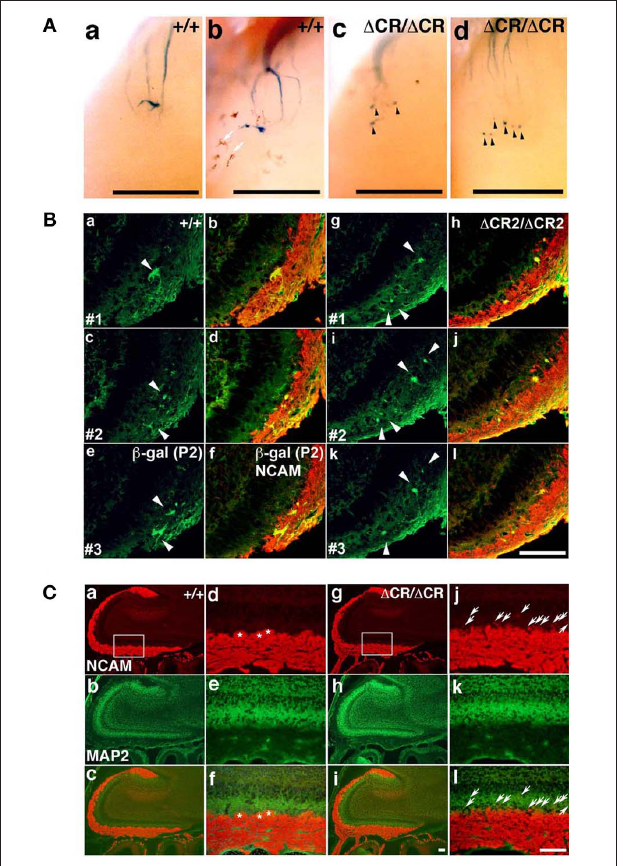
FIGURE 2 | Abnormal glomerular morphology in prenatal and neonatal Pcdha (cid:2) CR /(cid:2) CR mice. (A) Ectopic glomerulus-like structures of M71-expressing OSNs were found in neonatal Pcdha (cid:2) CR /(cid:2) CR mice by whole-mount observation. X-gal-stained lateral M71 glomeruli in whole-mounted OBs from WT (a, b) or Pcdha (cid:2) CR /(cid:2) CR ( (cid:2) CR/ (cid:2) CR ) (c, d) mice at P0. In Pcdha (cid:2) CR /(cid:2) CR mice, abnormal axonal projections from the olfactory nerve were often detected (arrowheads). Melanocytes (arrows) were visible on some of the whole-mount preparations of the olfactory bulbs. Scale bars, 500 μ m. (B) Sectional analysis of the coalescence of WT (a–f) and Pcdha (cid:2) CR 2 /(cid:2) CR 2 (g–l) P2 axons on embryonic day (E) 17.5. Serial sections of OBs were double-labeled with anti- β -galactosidase (for P2, green) and anti-NCAM (red) antibodies. There were more P2 glomerulus-like structures (arrowheads) in the Pcdha (cid:2) CR 2 /(cid:2) CR 2 ( (cid:2) CR2/ (cid:2) CR2 ) mice (See Figure 3A ). Scale bar, 100 μ m. (C) OBs in WT (a–c) and Pcdha (cid:2) CR /(cid:2) CR mice (g–i) were double-labeled with anti-NCAM (red) and anti-MAP2 (green) antibodies. Due to the orientation shown in panels (d) and (j), in Pcdha (cid:2) CR /(cid:2) CR mice, the OSN axons appeared to extend beyond the normal confines of the glomerular layer and often terminated as an intensely stained spatially restricted and condensed structure (j and l, arrows). In addition, the primary axons terminated in less clearly defined glomeruli in Pcdha (cid:2) CR /(cid:2) CR ( (cid:2) CR/ (cid:2) CR ) than in WT ( + / + ) mice. Primary glomerular structures could be detected in WT (d, f, asterisks) but not Pcdha (cid:2) CR /(cid:2) CR mice (j, l) (See Figures 6B,C ). Immunostaining with anti-MAP2 (green) antibody did not show significant differences between WT (e) and Pcdha (cid:2) CR /(cid:2) CR (k) mice. Scale bar, 100 μ m.